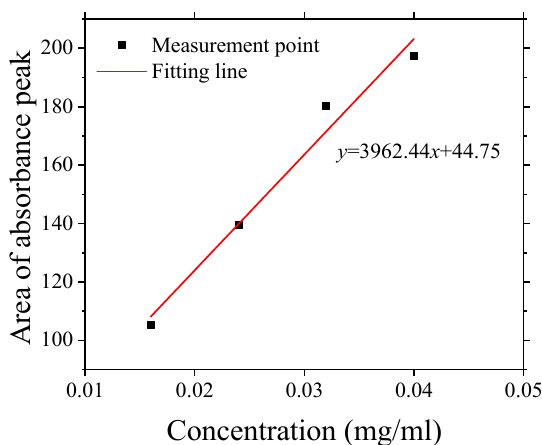
Figure 2. The relationship between the concentration of graphene oxide (GO) solution purchased commercially and the area of absorption peak.